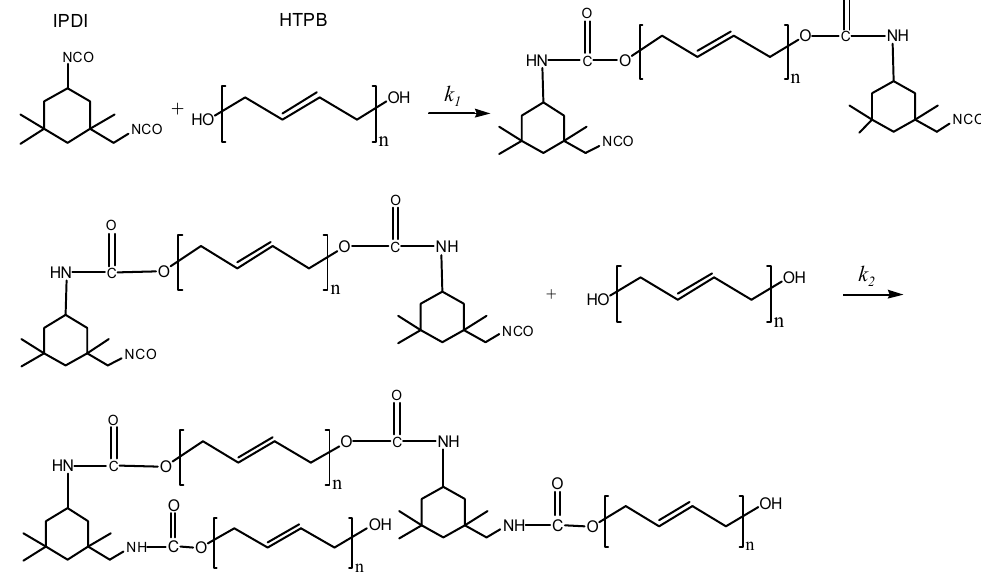
Figure 6. Curing process of HTPB-IPDI binder system.